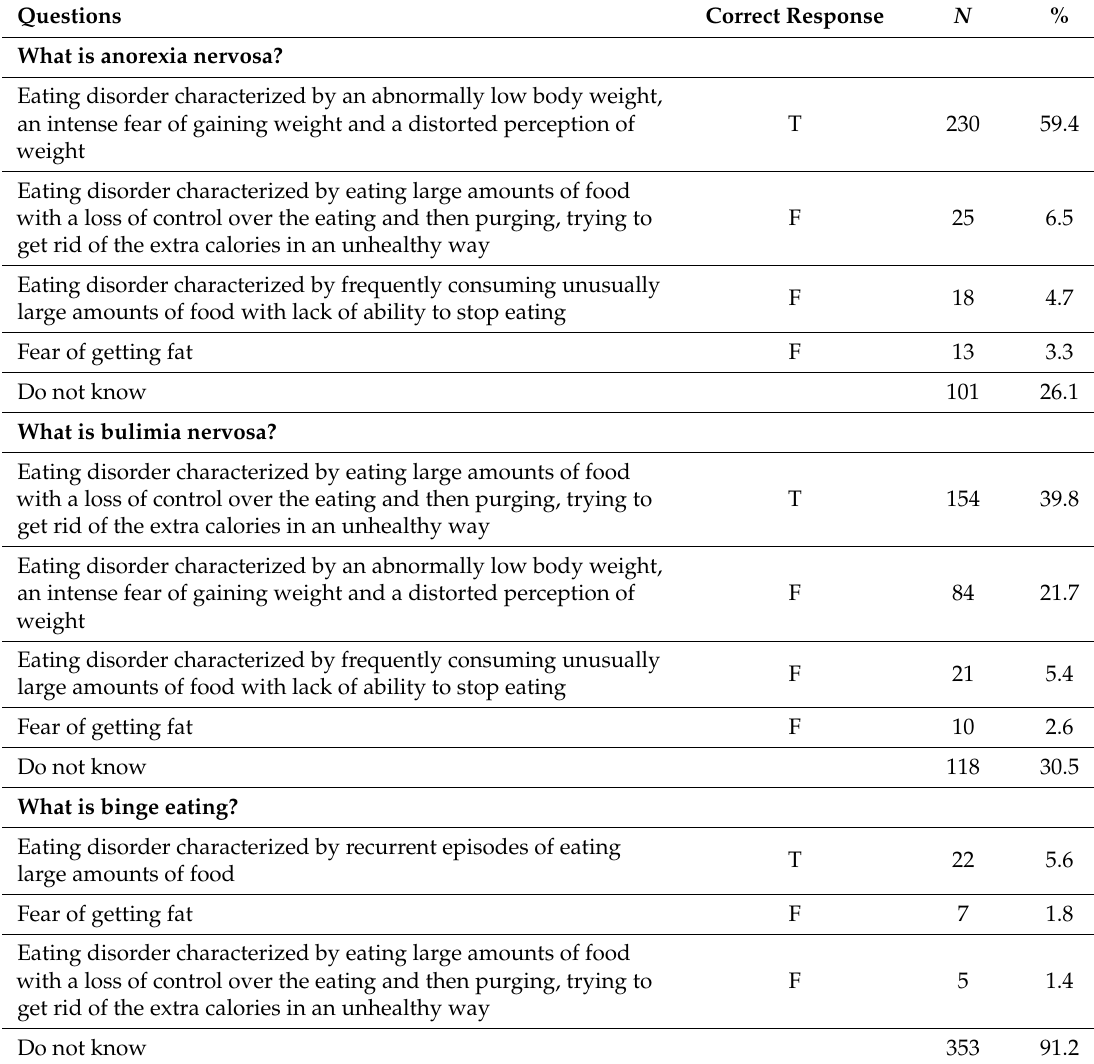
Table 2. Responses of the participants regarding knowledge of eating